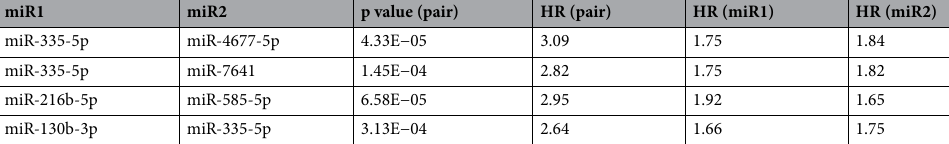
miR1 miR2 p value